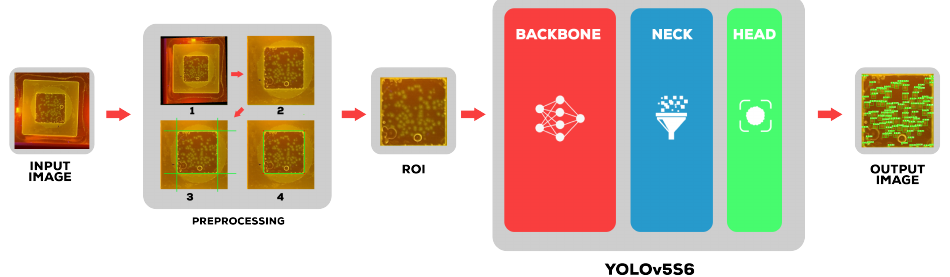
Figure 2. General structure of the proposed